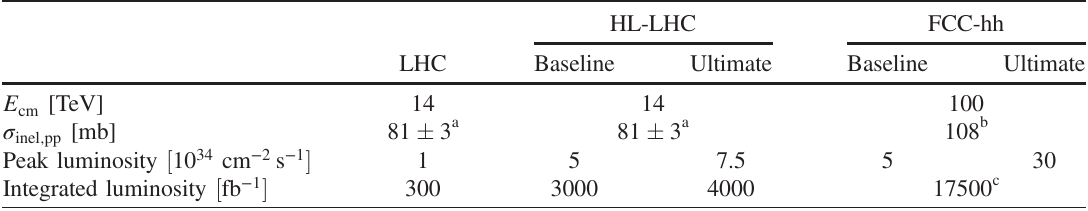
TABLE I. Parameters contributing to the radiation load.